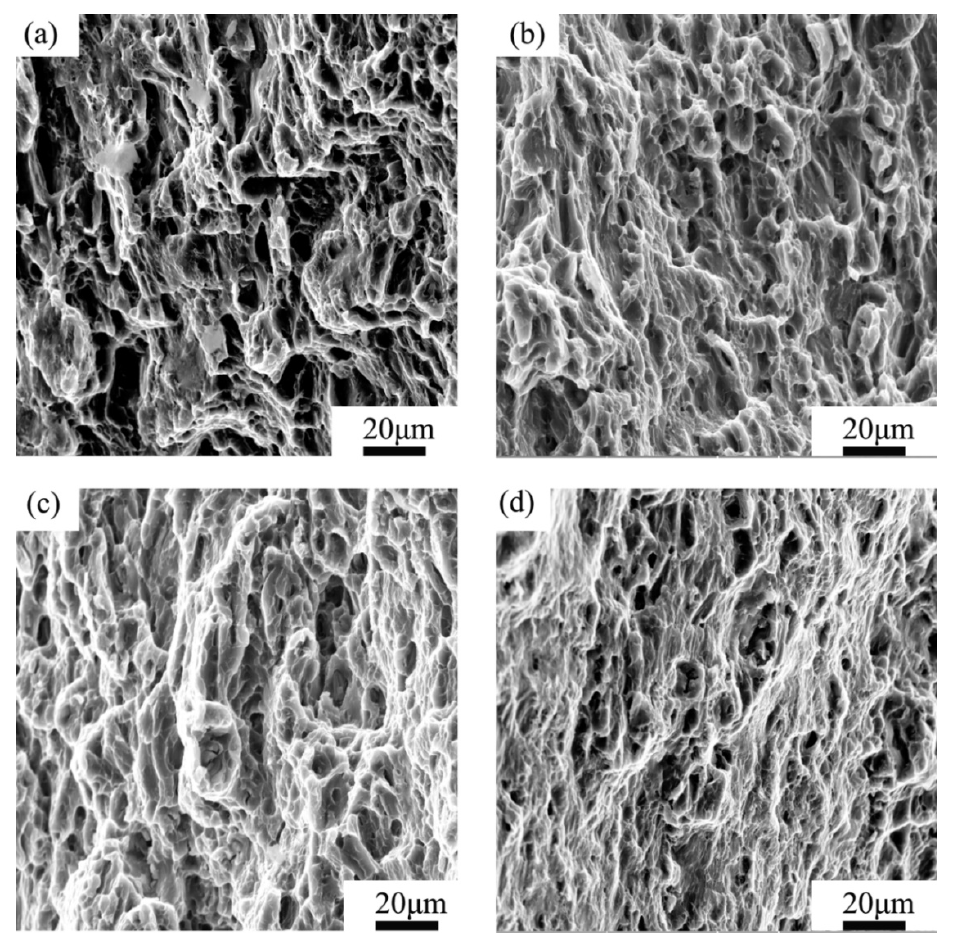
Figure 10. Tensile fracture surfaces of as-extruded alloy sheets stretched along the ED: ( a ) alloy 1, ( b ) alloy 2, ( c ) alloy 3, and ( d ) alloy 4.